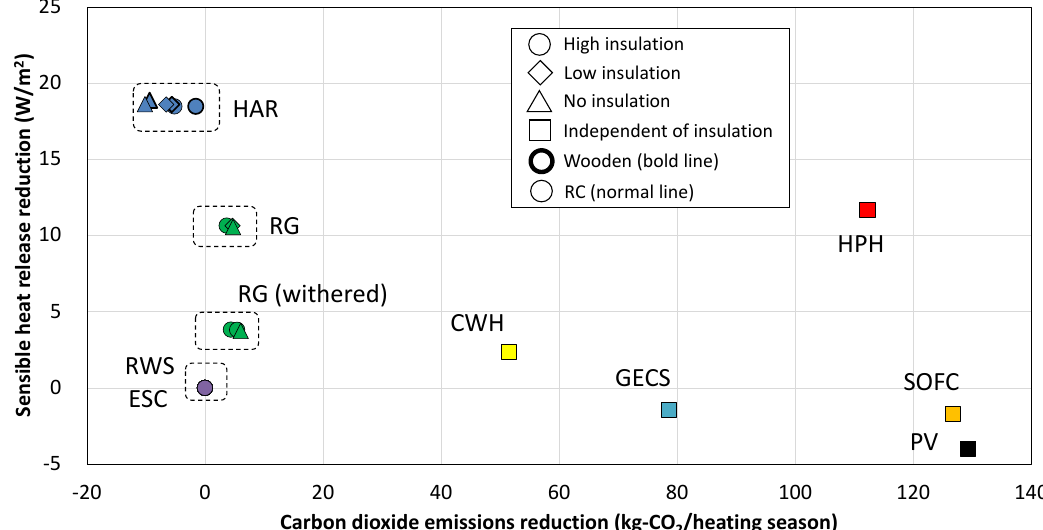
Figure 12. Diurnal (24-h) average reduction in sensible heat release on an average value of sunny days in February versus total winter (December–February) reduction in CO 2 emissions upon applying each countermeasure.